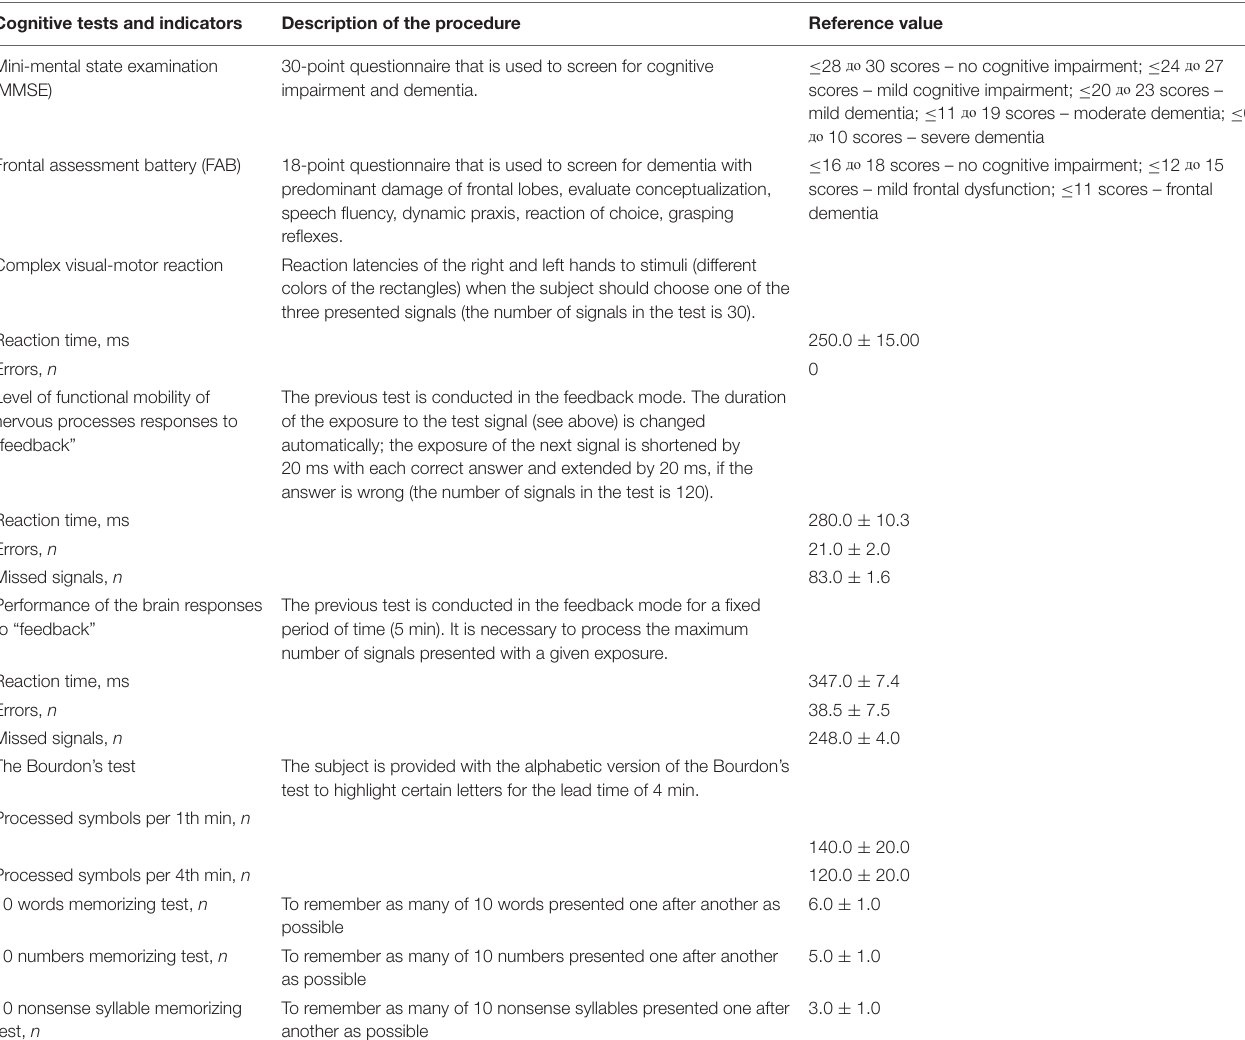
TABLE 3 | Cognitive test battery for assessing cognitive function in CABG